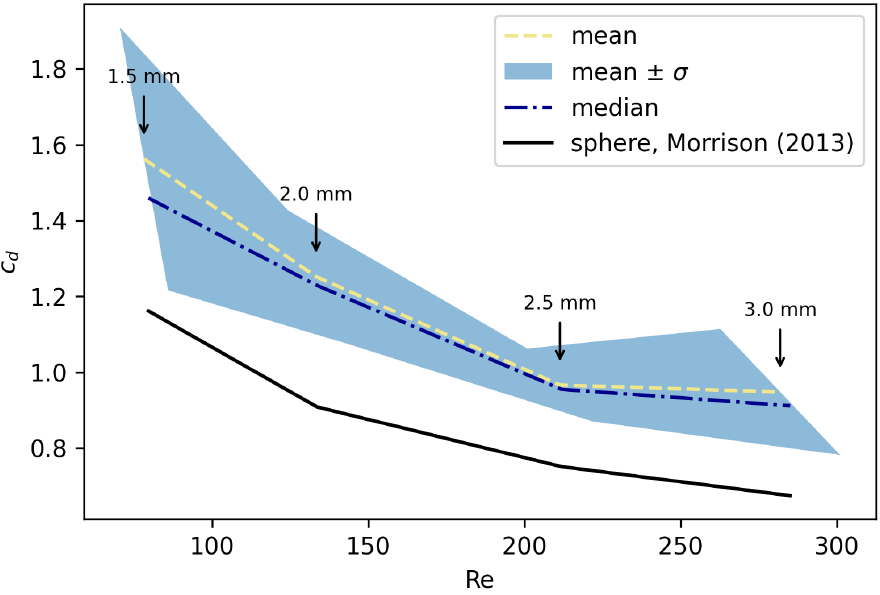
Figure 7. Correlation of drag coefficient and Reynolds number for particle group B.